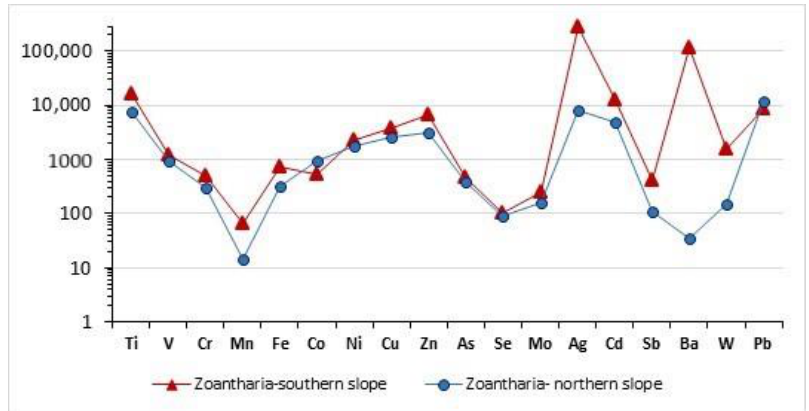
Figure 14. Distribution pattern of the trace element BCF in body and shell of Brachiopoda.